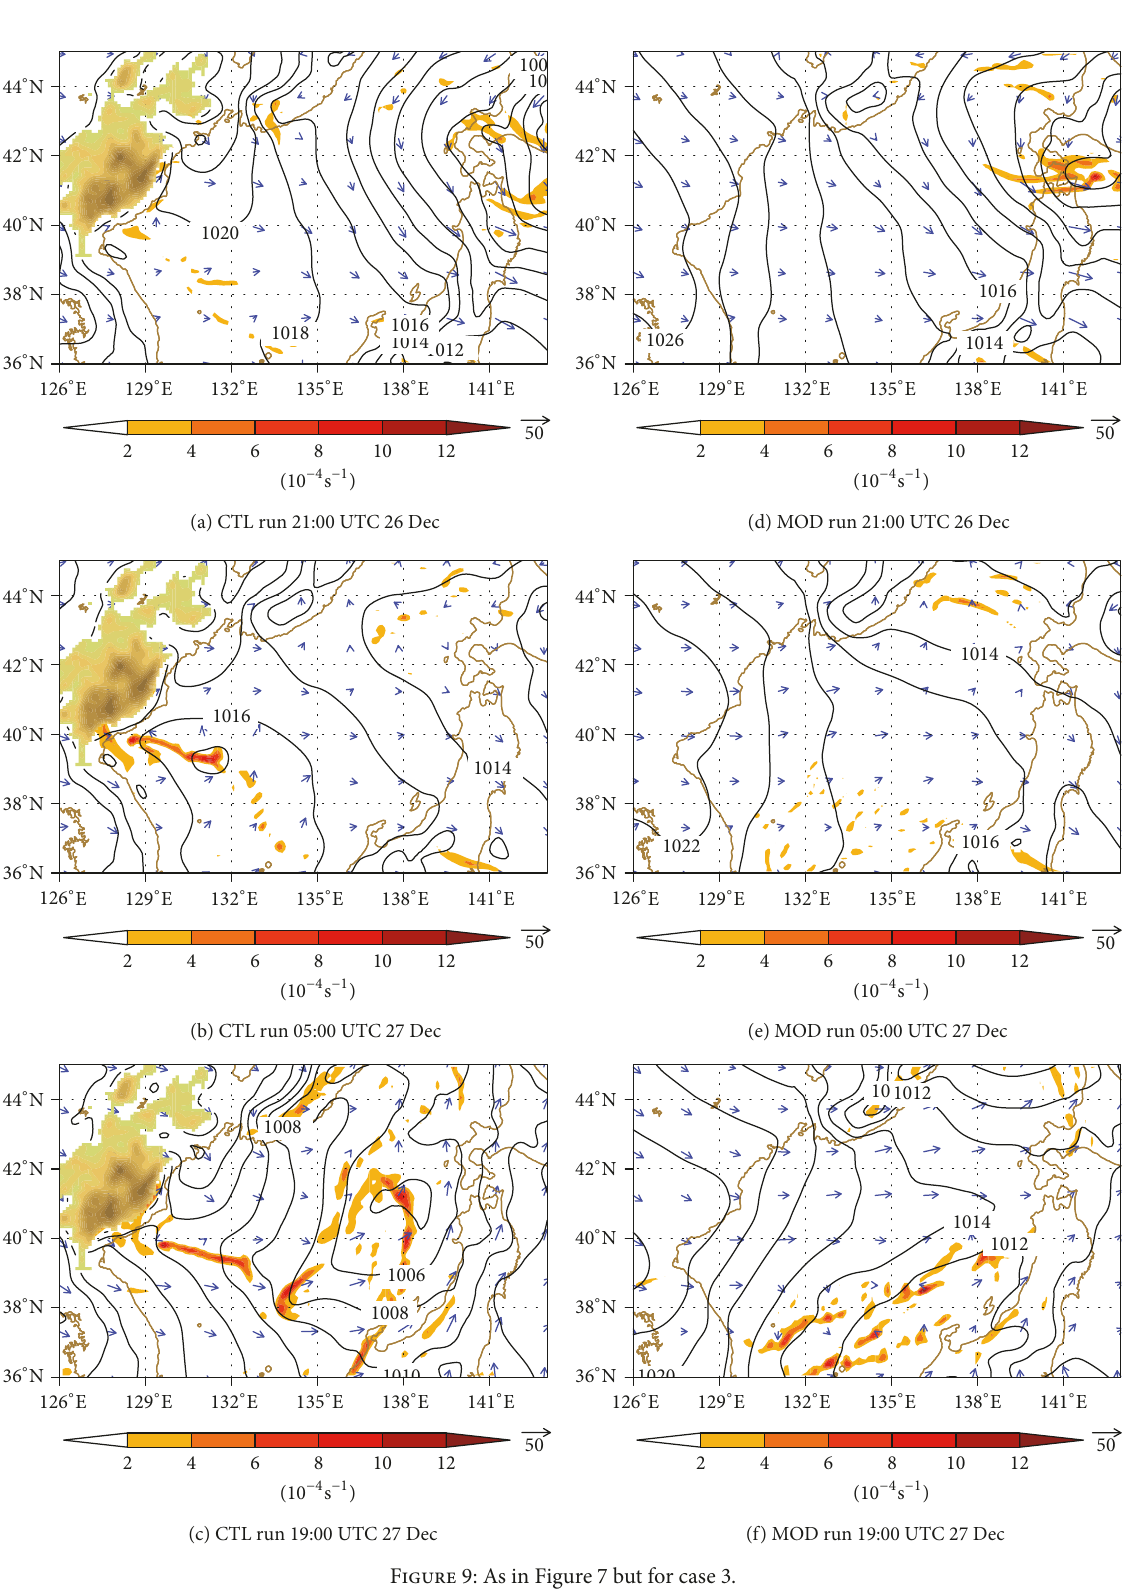
Figure 9: As in Figure 7 but for case